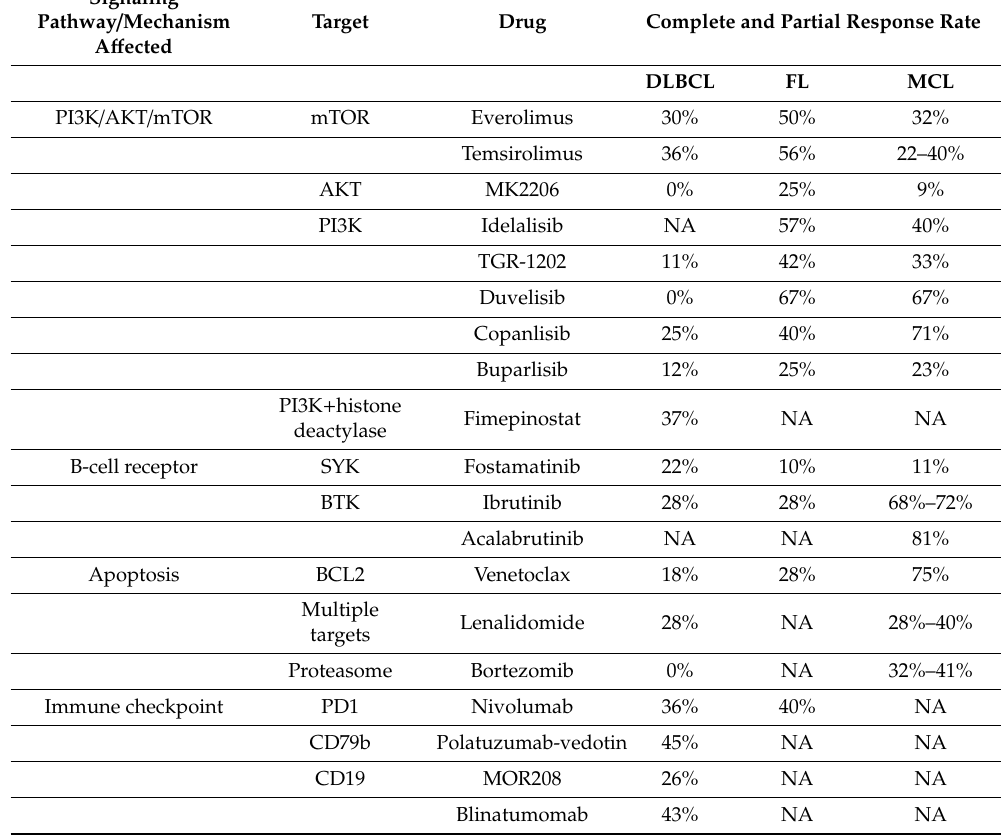
Table 1. Summary of newer single-agent treatment options that are being investigated for R / R DLBCL, FL and